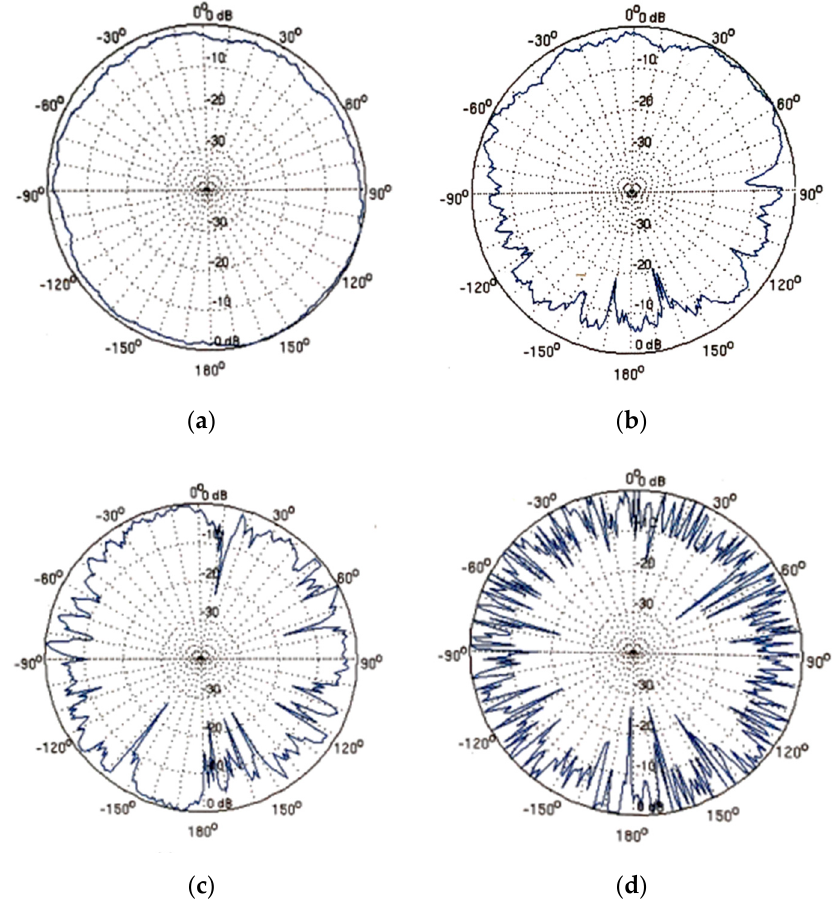
Figure 6. Radio propagation patterns for different degrees of irregularity (DOI). ( a ) DOI = 0.05; ( b ) DOI = 0.1; ( c ) DOI = 0.2; ( d ) DOI = 1.